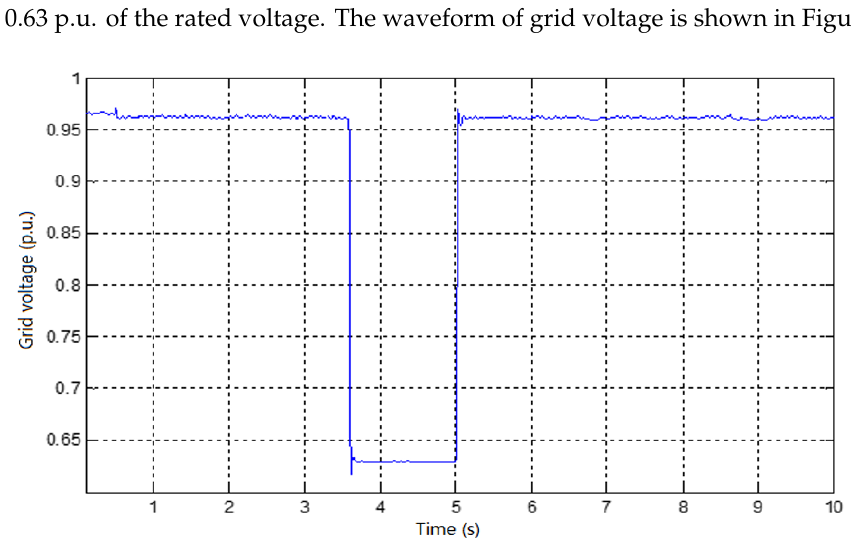
Table 3. Parameter identification results under large disturbance of grid voltage.